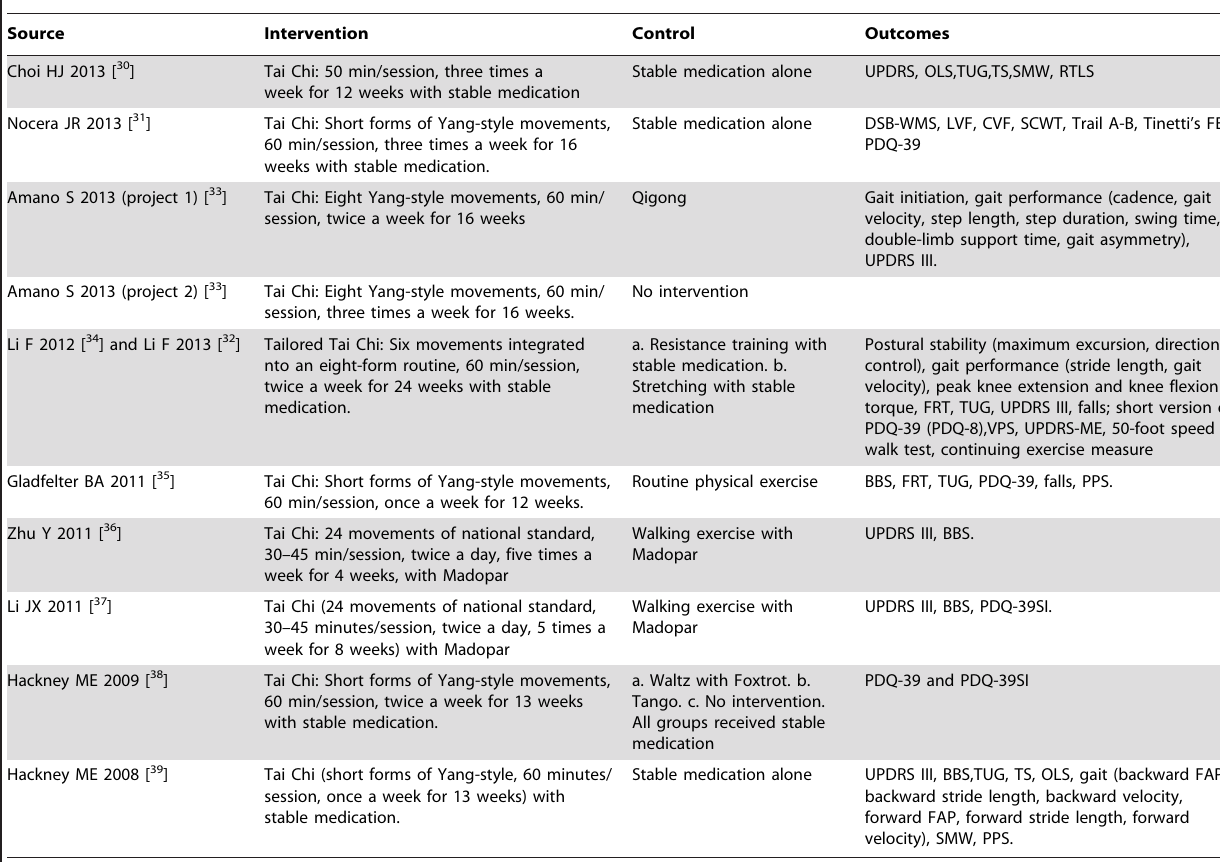
Table 2. Characteristics of the included